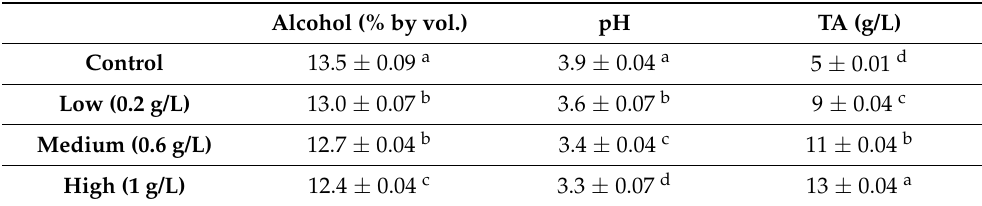
Table 5. Basic wine parameters post fermentation. Each treatment rep was analyzed in duplicate. Results presented are averages over treatment replicates. abcd Mean values within a column followed by the same letter were not significantly different ( p > 0.05). 0.2 g/L, 0.6 g/L, and 1 g/L indicate the rate of Catazyme ® 25 L addition to treated